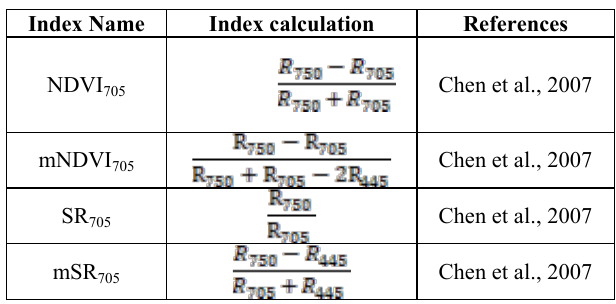
Table 1.Remote sensing Indices for Chlorophyll measurement